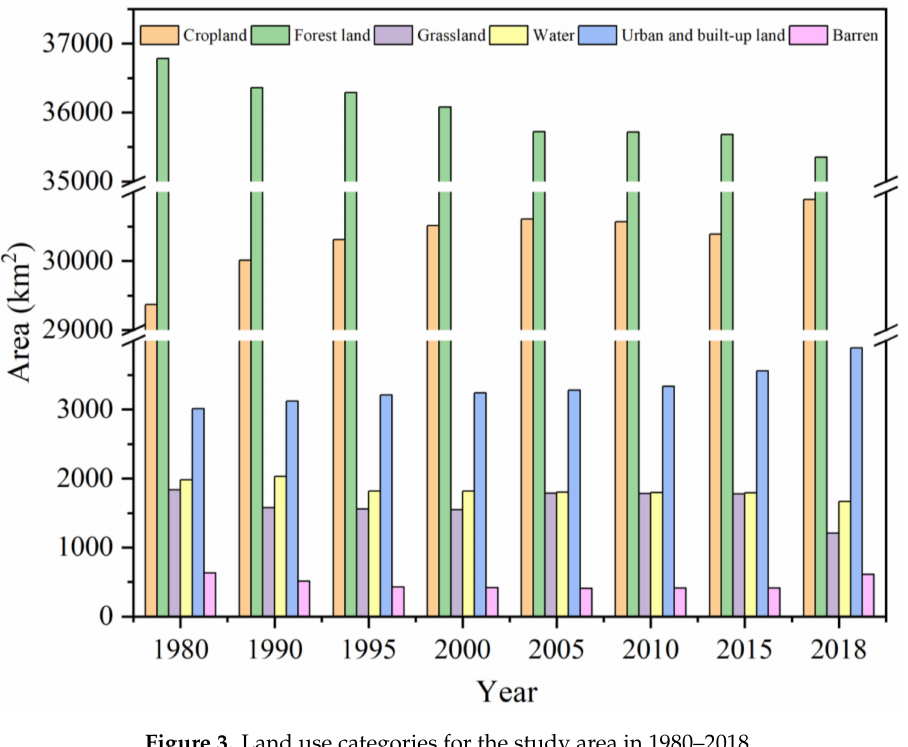
Figure 3. Land use categories for the study area in 1980–2018.